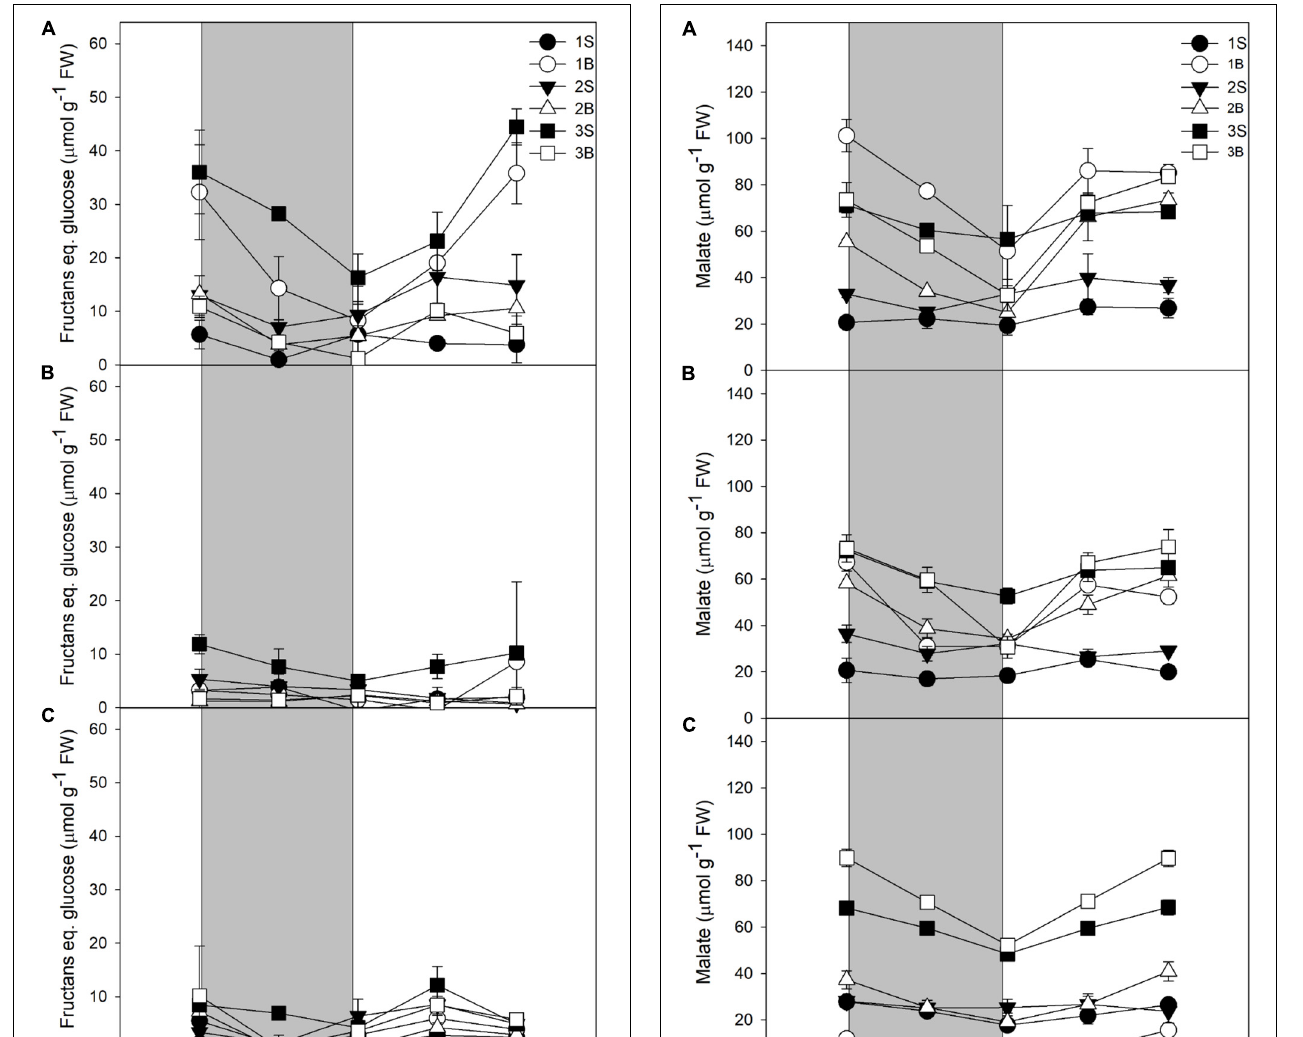
levels in third sheaths did not varied amongst the treatments while in the first and second blade it showed a reduction in its levels when light intensity decreased ( Figure 4 ). The youngest blade – third blade – showed no difference in malate levels between HL and ML but increased in the third blade of plants